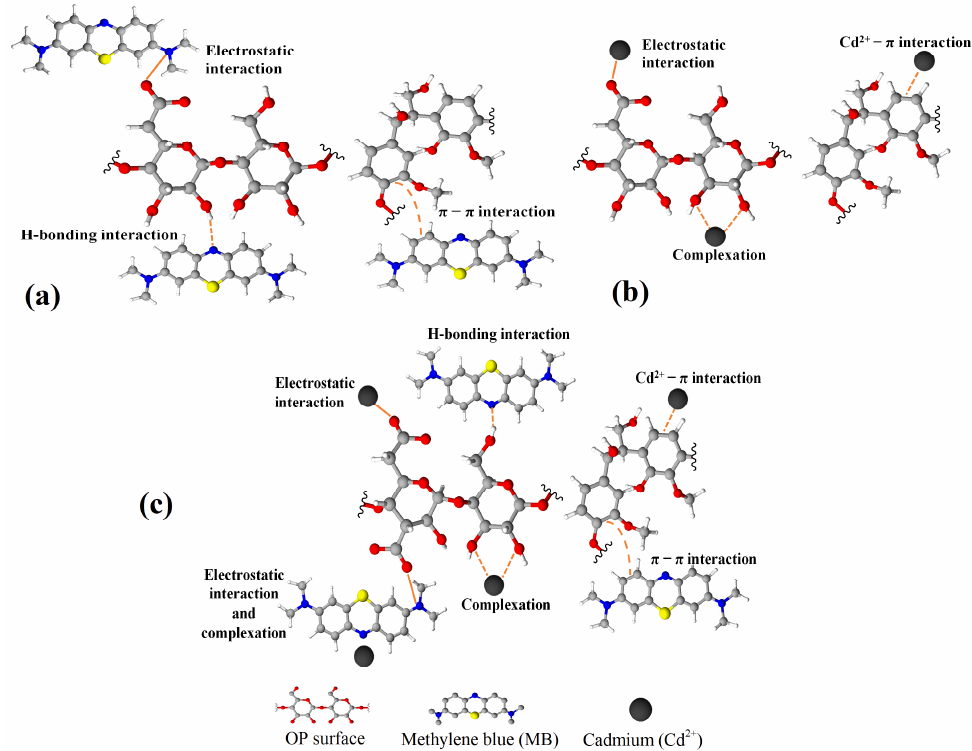
Figure 7. Schematic representation of the adsorption mechanisms on OP surface. ( a ) Interaction with MB. ( b ) Interaction with Cd 2+ . ( c ) Interactions with binary systems of MB and Cd 2+ .